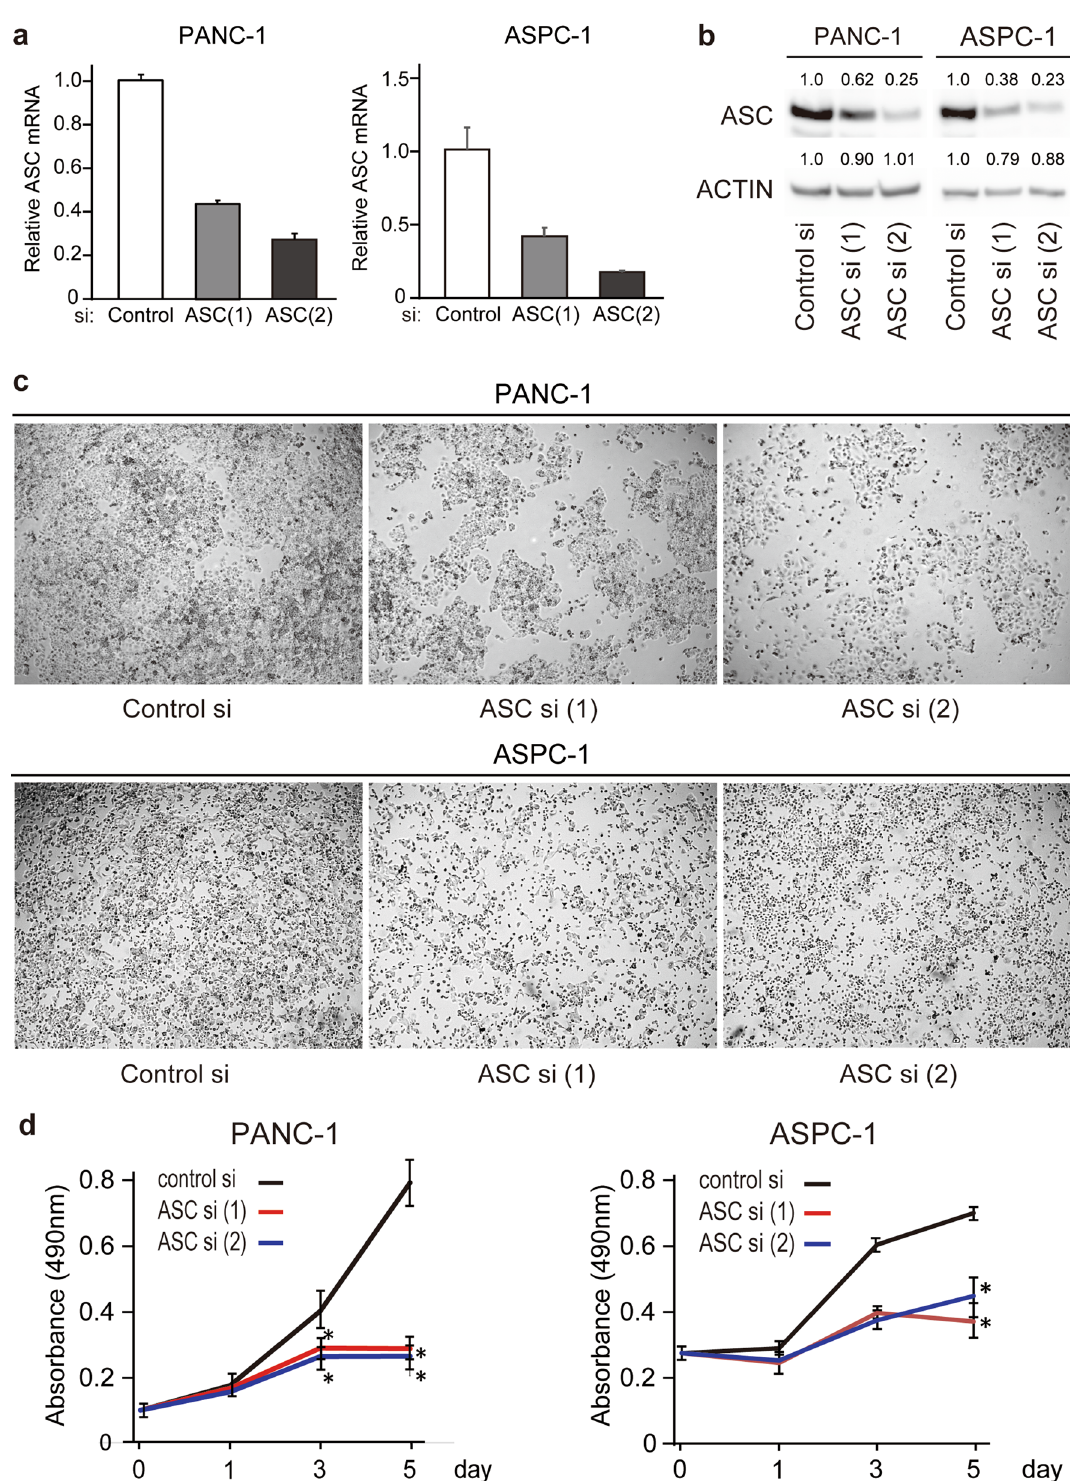
Figure 4. Changes in PDAC cells following ASC silencing. ( a ) ASC mRNA expression following transfection with control and ASC siRNA. Data represent the mean ± standard error of the mean of three to four replicates. ( b ) Western blot analysis of ASC protein expression following transfection with control and ASC siRNA. Relative densitometry data as compared with controls are given for each lane. The original gel images of Western blotting are shown in Fig. S7. ( c ) Photographs of wells on day 5 after siRNA transfection. ( d ) Viability of cells transfected with control or ASC siRNA. Data represent the mean ± standard error of the mean of three replicates. *p < 0.05, vs. control, Student’s t